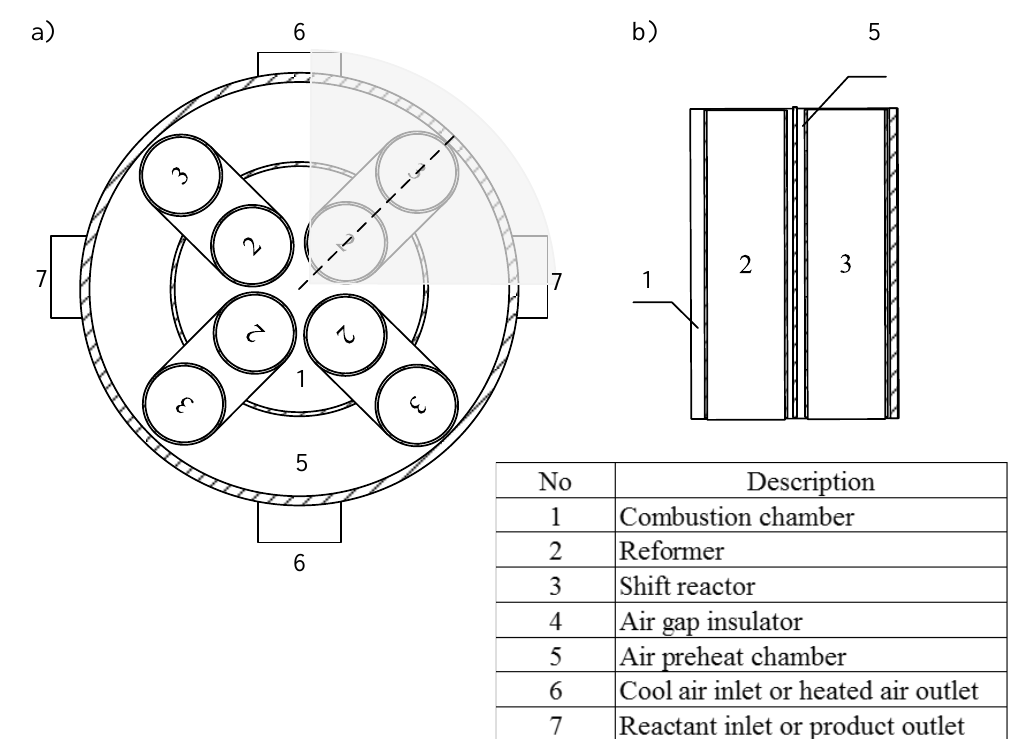
Figure 2. Configuration of CHIRS (I) shown in ( a ) top view and ( b ) cross sectional view (dotted line).